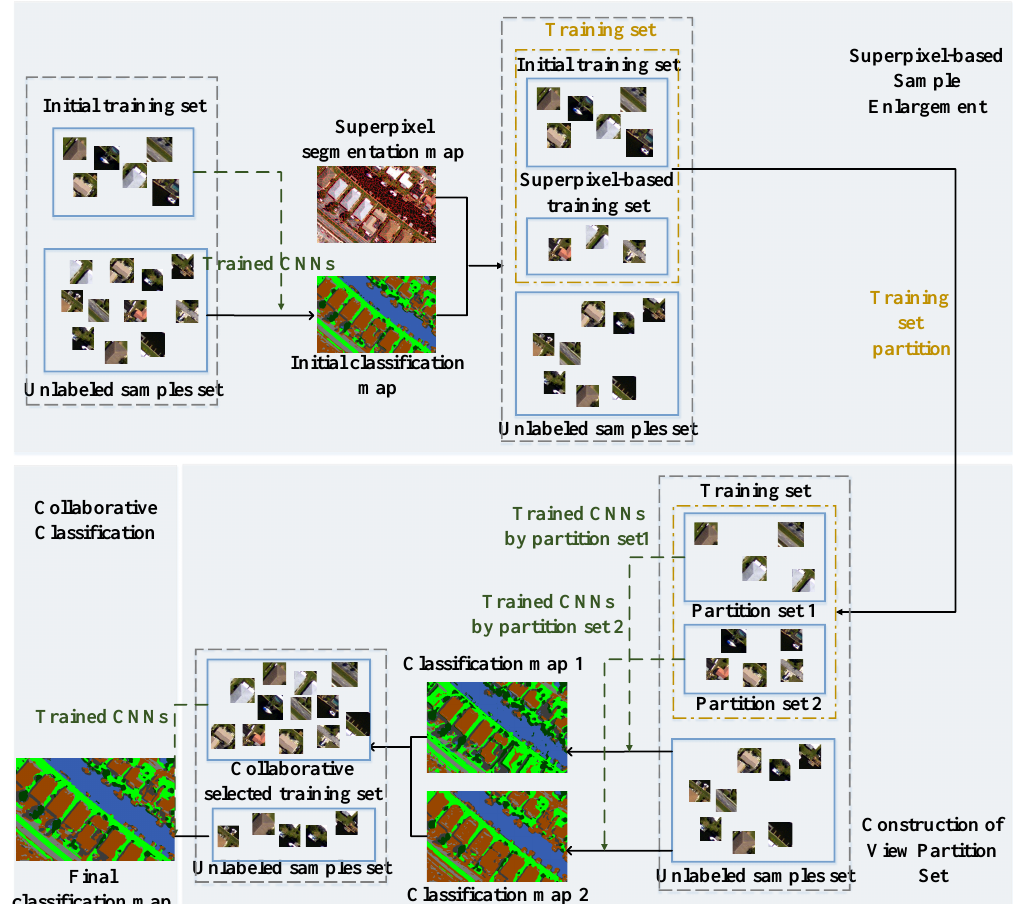
Figure 3. Framework of the proposed method. The proposed method consists of three stages: (1) Superpixel-based sample enlargement, which is to enlarge the training set initially. (2)